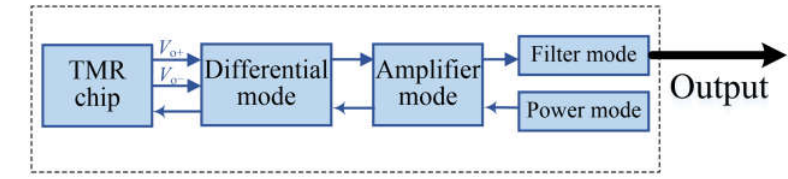
Figure 4. Hardware circuit block diagram.